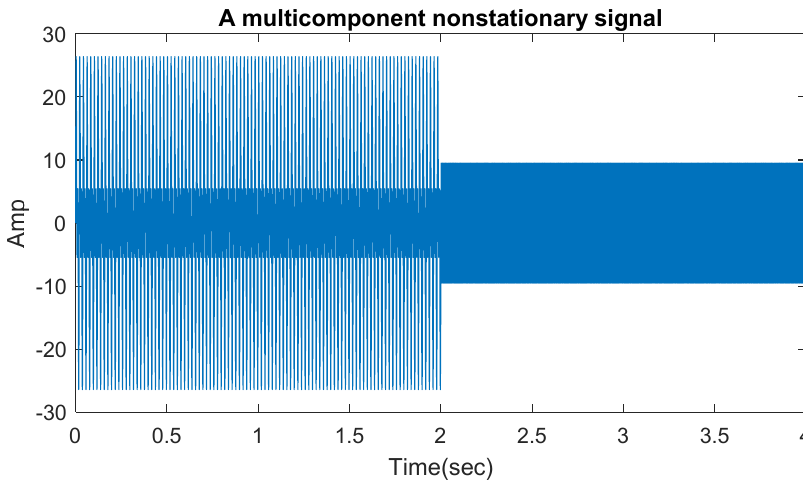
Figure 1. A multicomponent nonstationary signal.